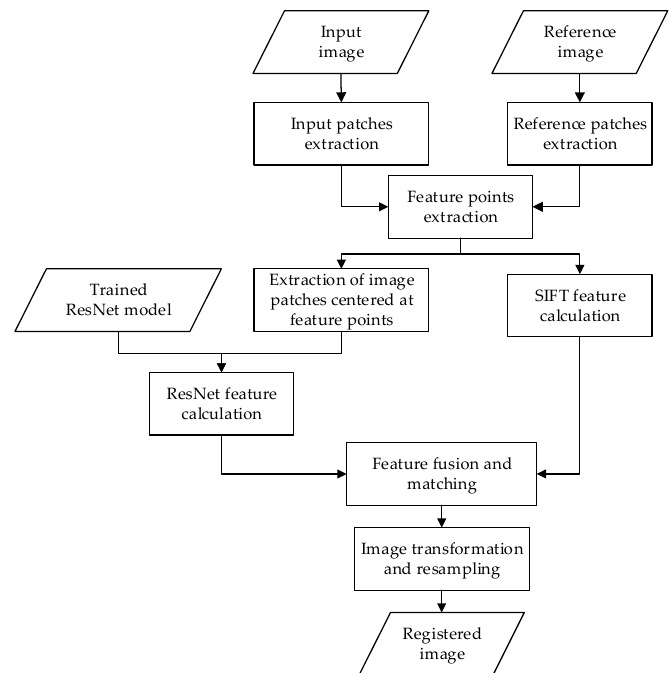
Figure 2. The image registration flowchart for the combination of ResNet and SIFT.